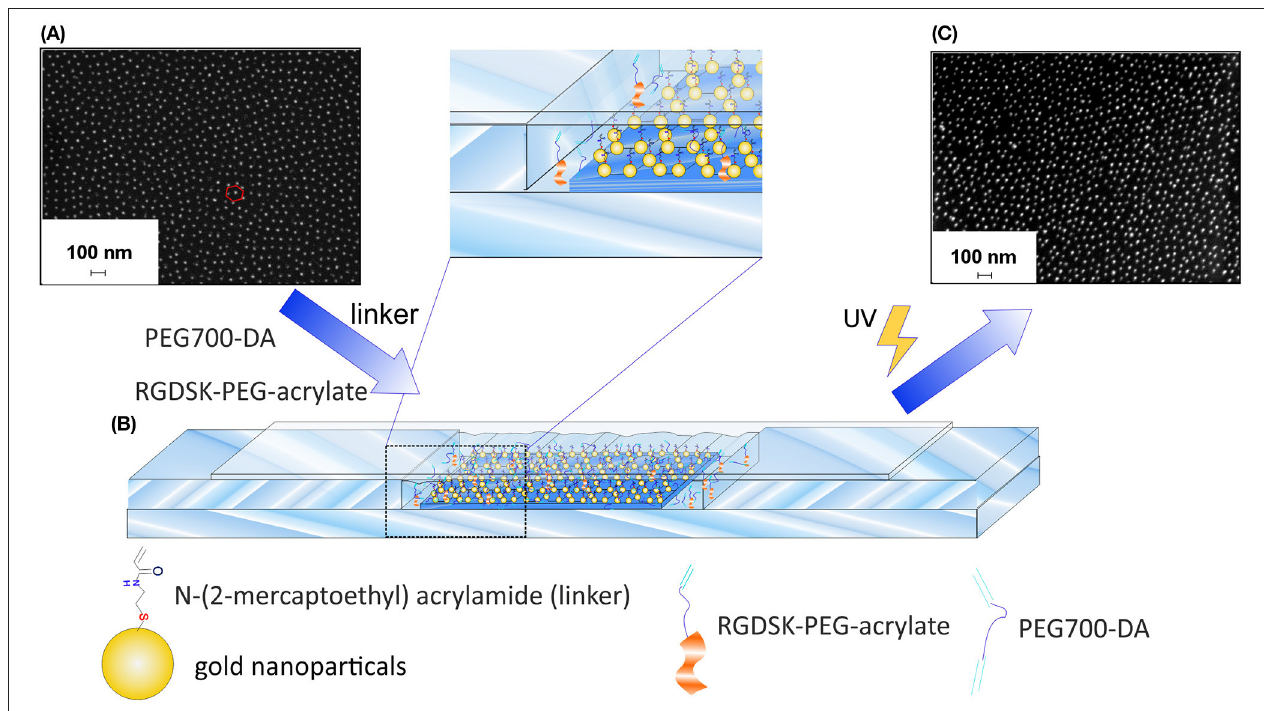
FIGURE 1 | Preparation of GNP-hydrogels. (A) SEM image of quasi-hexagonal GNP-40 glass substrates before the transfer process, (B) experimental set-up for the preparation of GNP-hydrogels by UV-light induced free-radical copolymerization of PEG700-DA, RGDSK-PEG-acrylate and N-(2-mercapto-ethyl) acrylamide linker, and (C) SEM image of GNP-hydrogel after the transformation